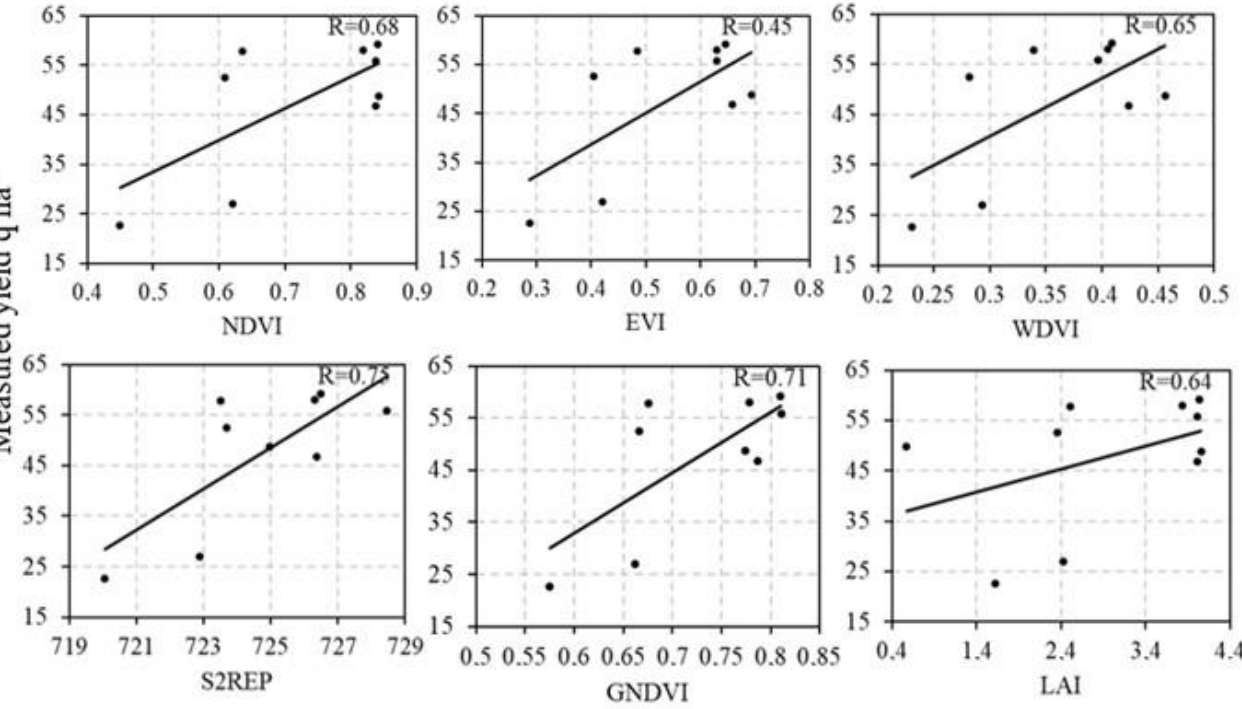
Figure 6. Sensitivity Analysis between Remote Sensing Indices and Crop Yield in the maturity stage (1 April 2021). Table 4. Yield estimation models for durum wheat using remote sensing